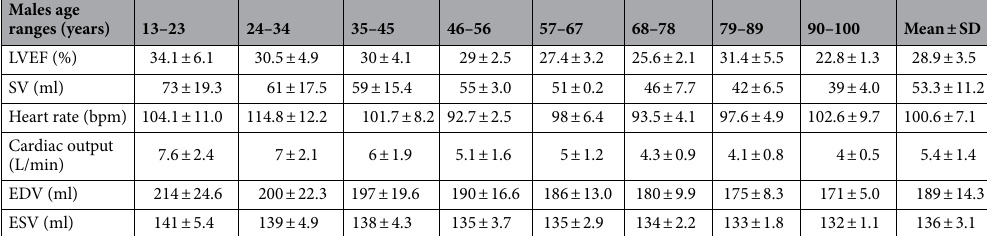
Table 6. LV volumes and systolic function by age decile in IHD male patients using CMRI. Left ventricle ejection fraction LVEF , Stroke volume SV , End diastolic volume EDV , End systolic volume ESV.